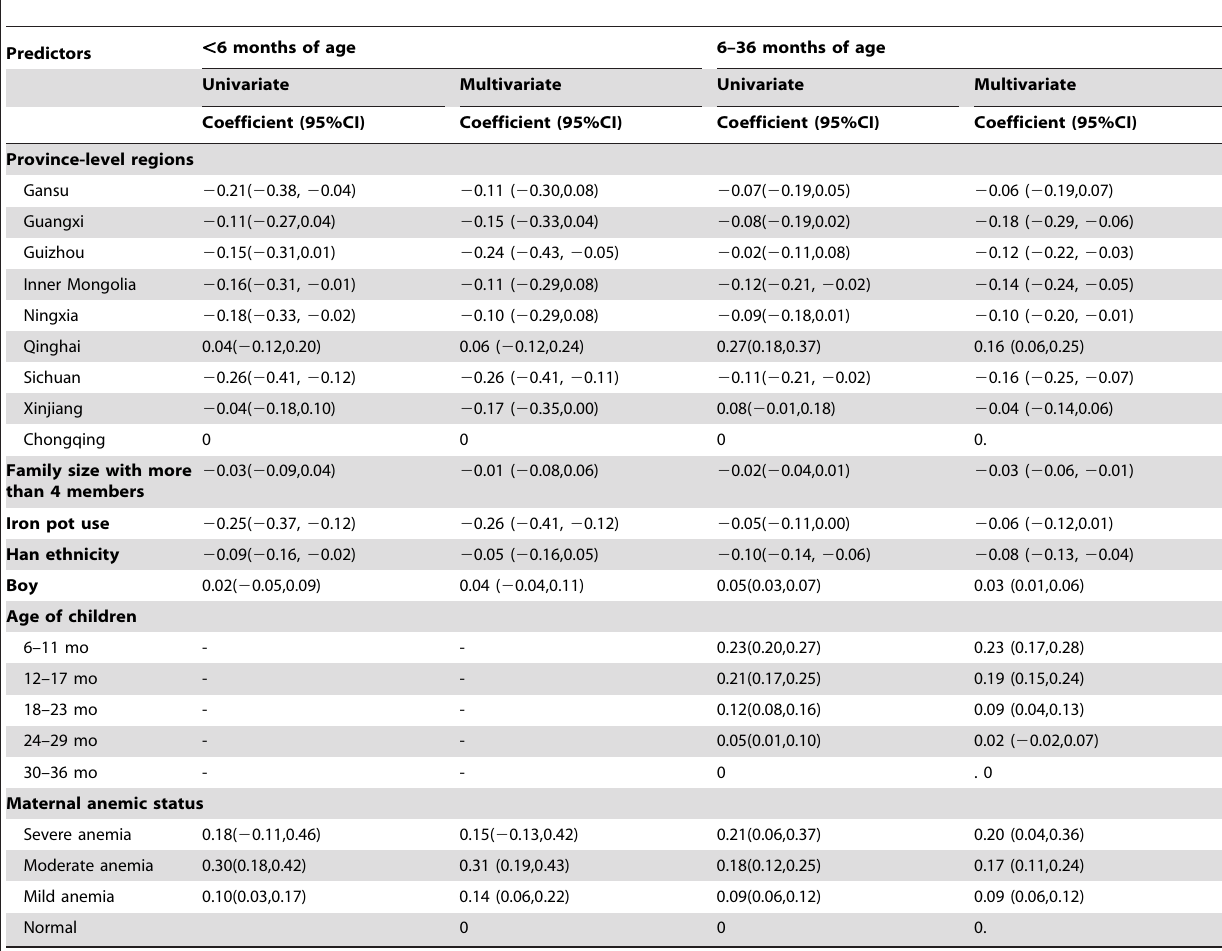
Table 3. Predictors of severity of anemia among children under 36 months old in rural western